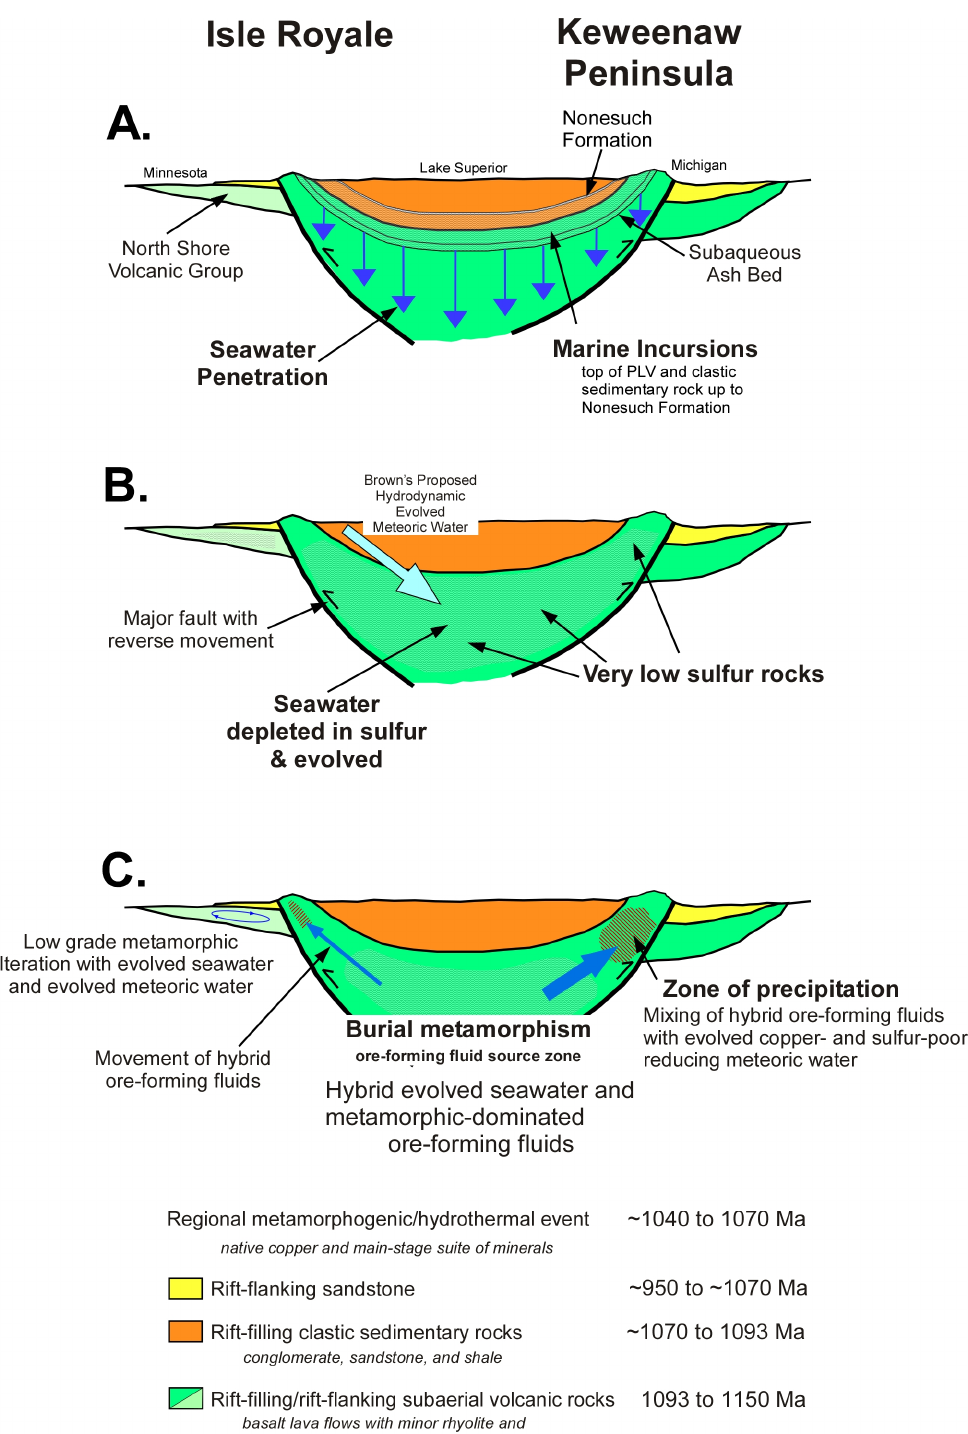
Figure 3. Cartoon geologic cross section illustrating the conceptual genetic model for the native copper deposits of the Keweenaw Peninsula. ( A ) Depositional infilling of the rift. ( B ) Initial burial prior to burial metamorphism. ( C ) Regional hydrothermal event synchronous with regional compression. Cartoon cross section faces north from Isle Royale to the Keweenaw Peninsula. Location shown in Figure 1. Modified from Bornhorst and Mathur [29].